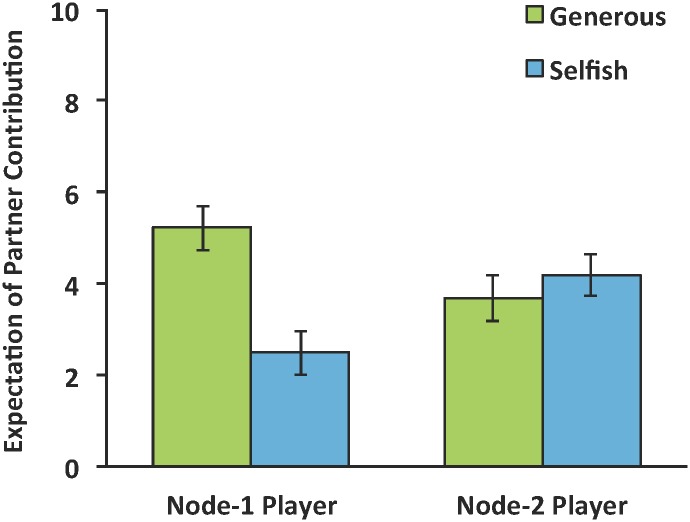
Participants’ expectations regarding partners’ contributions in Game 2.Node-1 players in the two chains held significantly different expectations. Node-2 players did not.